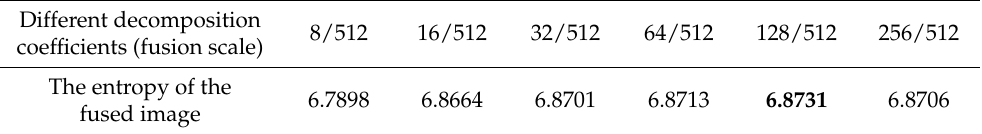
Table 1. Information entropy of fused images at different